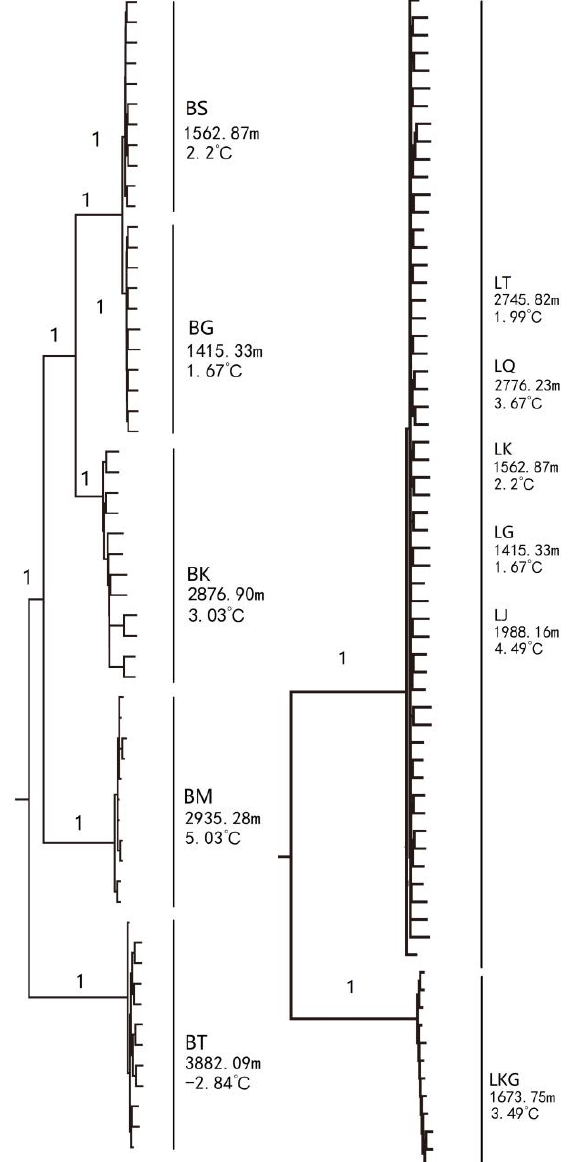
Figure 2. Phylogenetic trees of D. maculates ( left ) and G. dybowskii ( right ) constructed using the neighbor-joining (NJ) method (left — D. maculates ; right — G. dybowskii ). The node value means bootstrap support frequency.